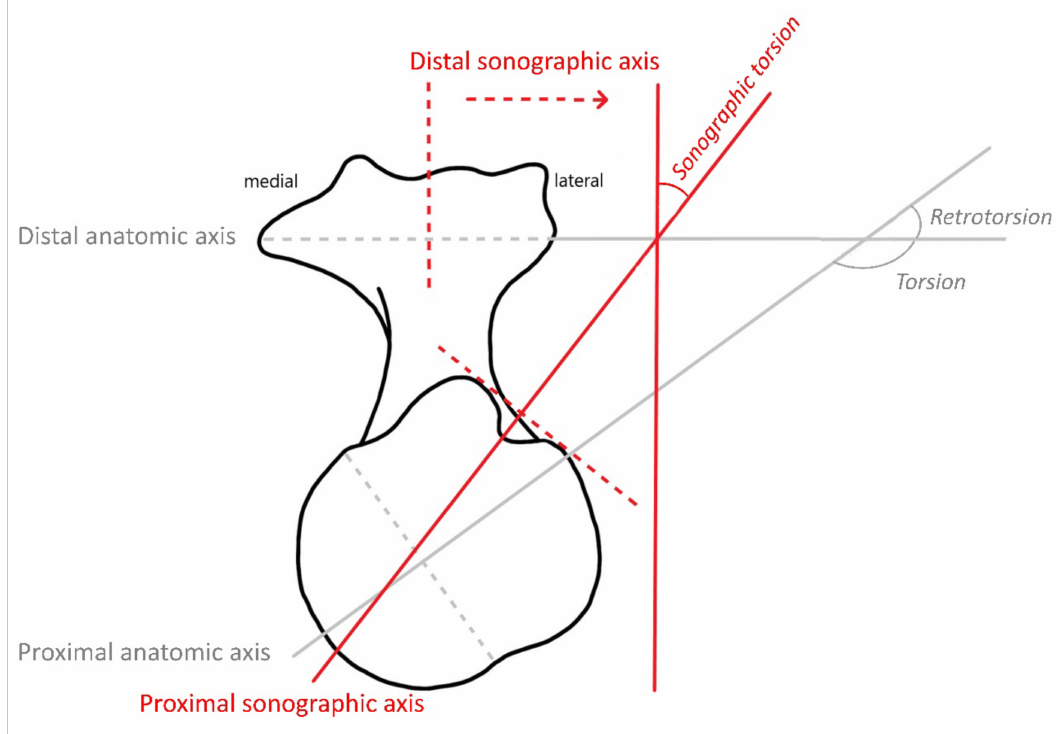
Figure 4. Humeral torsion, retrotorsion, and sonographic torsion in a right